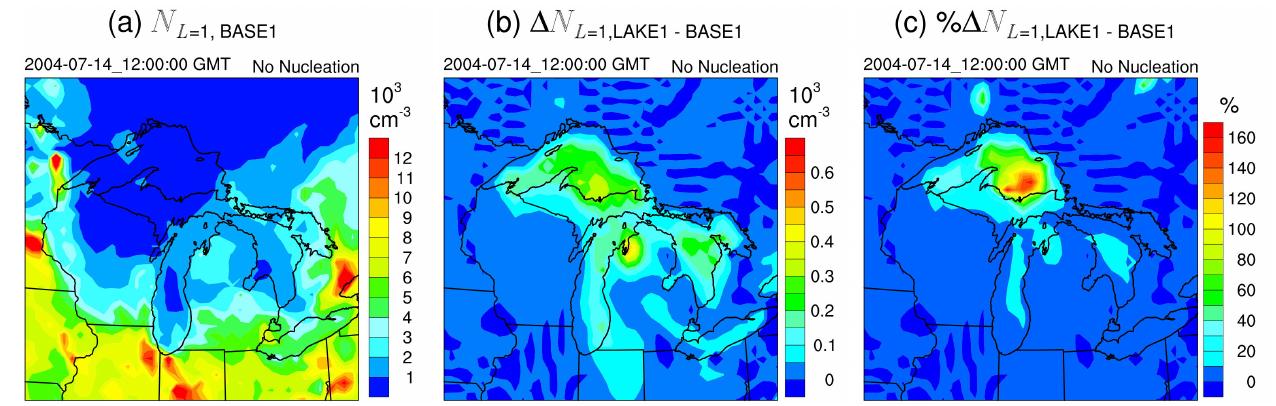
Fig. 5. Same as Fig. 3 except results are based on simulations with new particle formation turned off in the model.